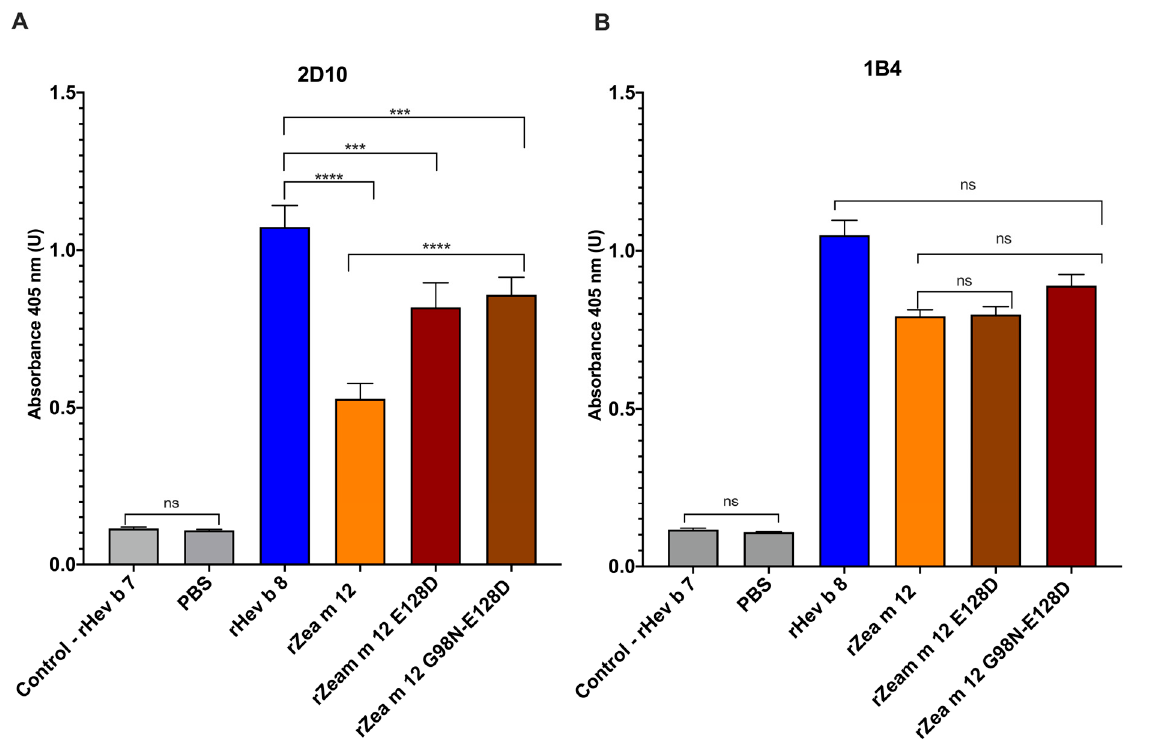
Figure 2. Characterization of recognition sites of mAbs (1B4 and 2D10) with Zea m 12 mutants. The bars show the recognition of rHev b 8, rZea m 12, the single mutant rZea m 12-E128D, and the double mutant rZea m 12 G98N-E128D measured by indirect ELISA. ( A ) mAb 2D10 strongly binds rZea m 12-E128D. ( B ) mAb 1B4 shows no significant difference in binding with rZea m 12 and its mutants. The negative controls are BSA and PBS as background control, and the positive control is rHev b 8. The standard deviation of three different experiments is shown. The statistical analysis was performed by Sidak’s multiple comparisons tests (ns, not significant, all p < 0.001 are summarized with three asterisks, and p < 0.0001 with four asterisks).